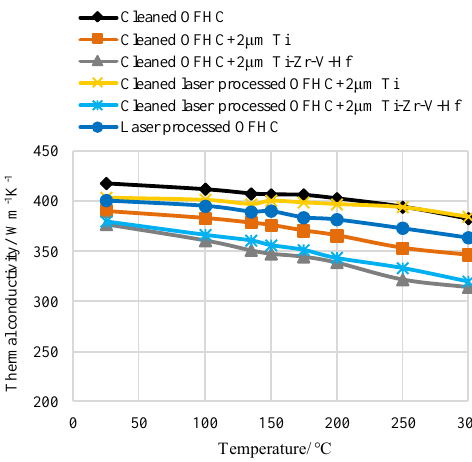
Figure 6. The thermal conductivities of laser processed OFHC, Ti film, and Ti–Zr–V–Hf coated laser processed OFHC substrates.